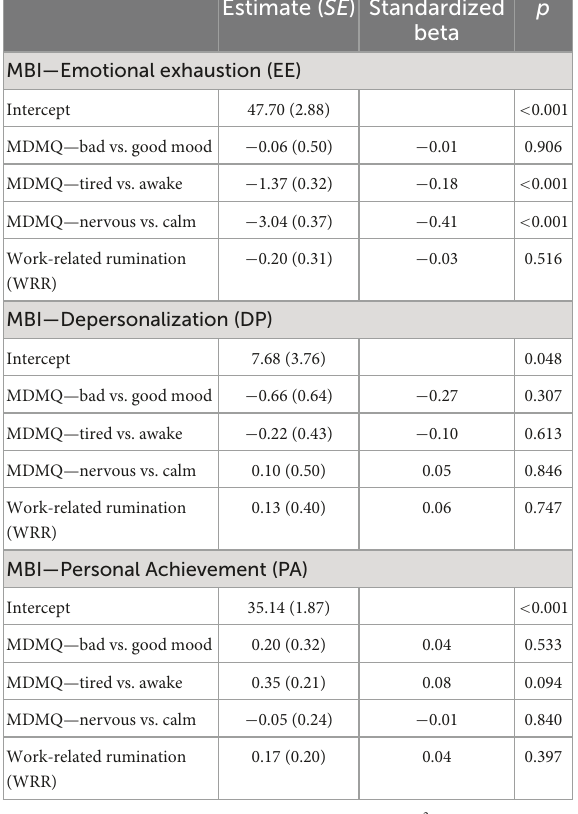
TABLE 5 Regression models for burnout (emotional exhaustion, depersonalization, personal achievement) based on daily rumination and well-being (good vs. bad mood, tired vs. awake, nervous vs.